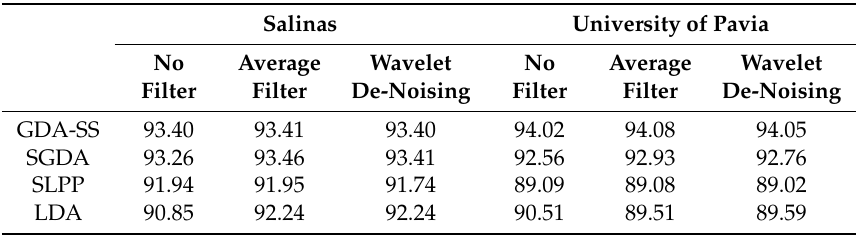
Table 5. Classification results after applying noise filtering